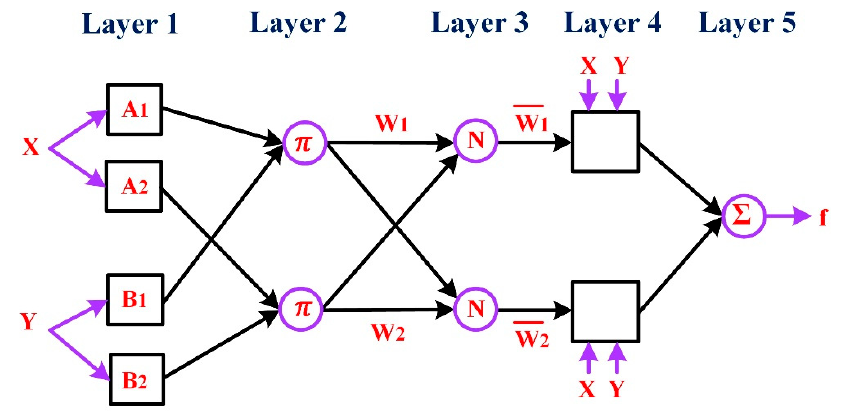
Figure 3. ANFIS architecture.